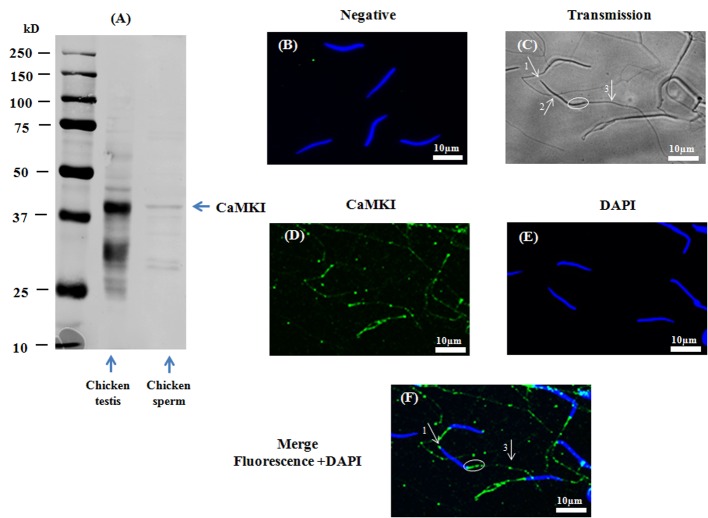
Presence and localization of CaMKI in chicken sperm.Chicken sperm lysates (45μg of protein) were analyzed by western blotting using anti- CaMKI as primary antibody. Cell lysates from chicken muscle (40μg of protein) were used as positive control. A band of approximately 41kDa for CaMKI was detected (3A). Indirect immunofluorescence of chicken sperm was carried out with the same antibody. Negative control: primary antibody was not added (3B). White arrows and circles in transmission images indicate areas of the acrosome (arrow 1), the nuclei (arrow 2), the midpiece (circles), and the principal piece of the flagellum (arrow 3) in sperm (3C). Immunofluorescence staining of CaMKI (3D, green) was conducted; nuclei were stained with DAPI (3E, blue). Merged images of fluorescence with DAPI staining are shown in Fig 3F (white arrows indicate regions containing CaMKI immunoreactivity: arrow 1: acrosome; arrow 3: principle piece; circle: midpiece). Scale bar: 10μm.